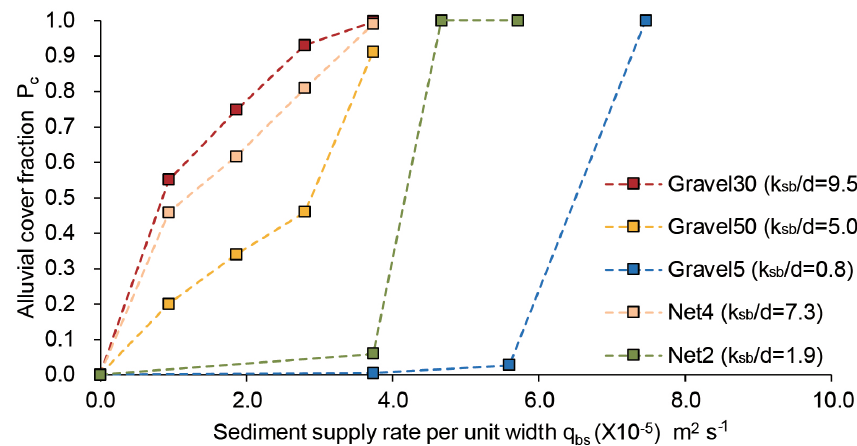
Figure 5. Variation in alluvial cover fraction ( P c ) with sediment supply.